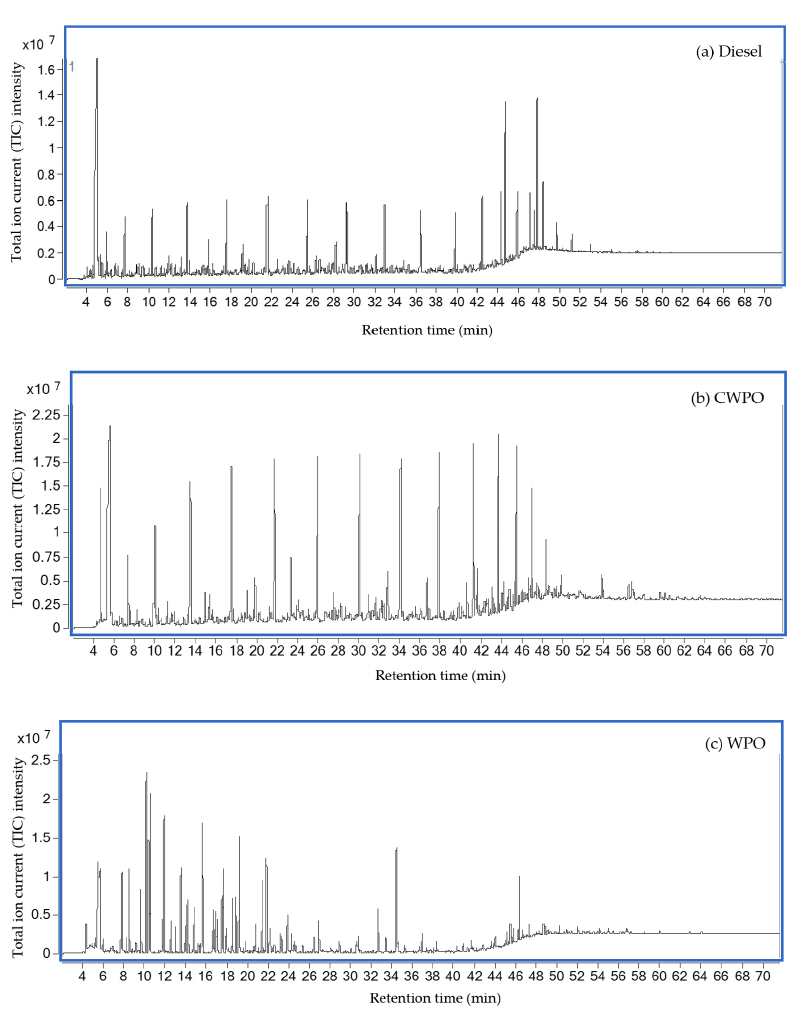
Figure 3. GC–MS chromatogram for ( a ) Diesel, ( b ) CWPO, and ( c )